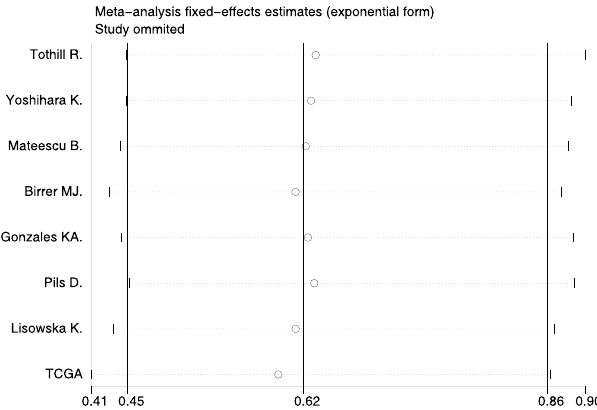
Figure 4. Sensitivity analysis on the relationships between IL-6R mRNA expression and overall survival in ovarian cancer